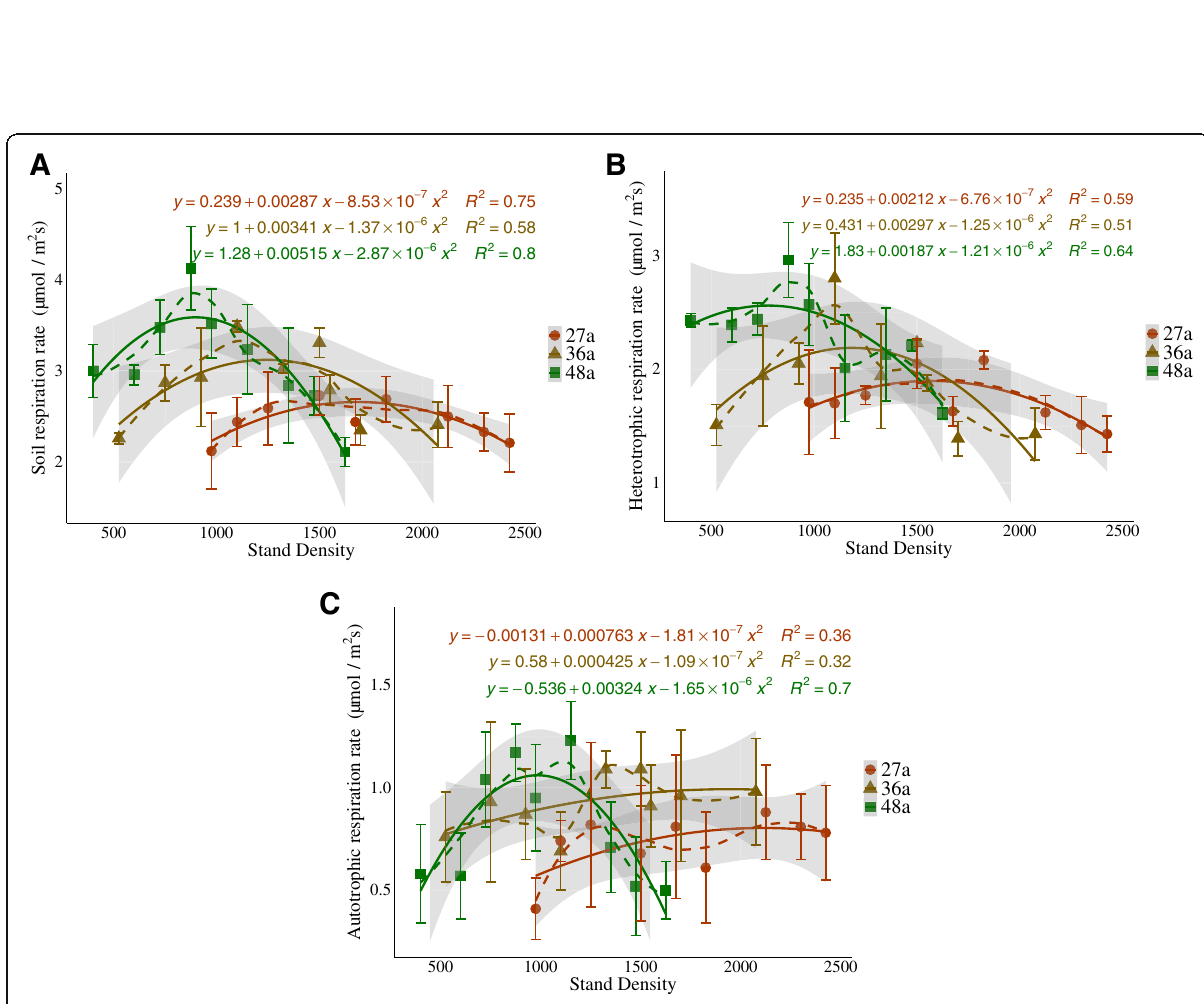
Fig. 3 Variations in the Rs, Rh, and Ra of the differently aged stands and densities. Error bars show the standard deviation (SD). Shaded areas represent confidence intervals. 27a, 27-year-old stand; 36a, 36-year-old stand; 48a, 48-year-old